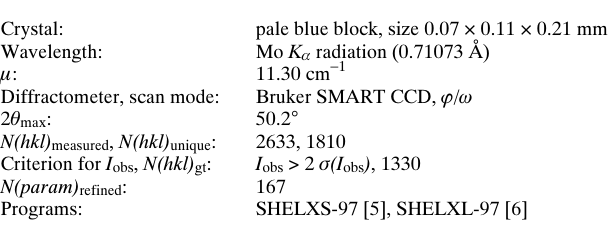
Table 1. Data collection and